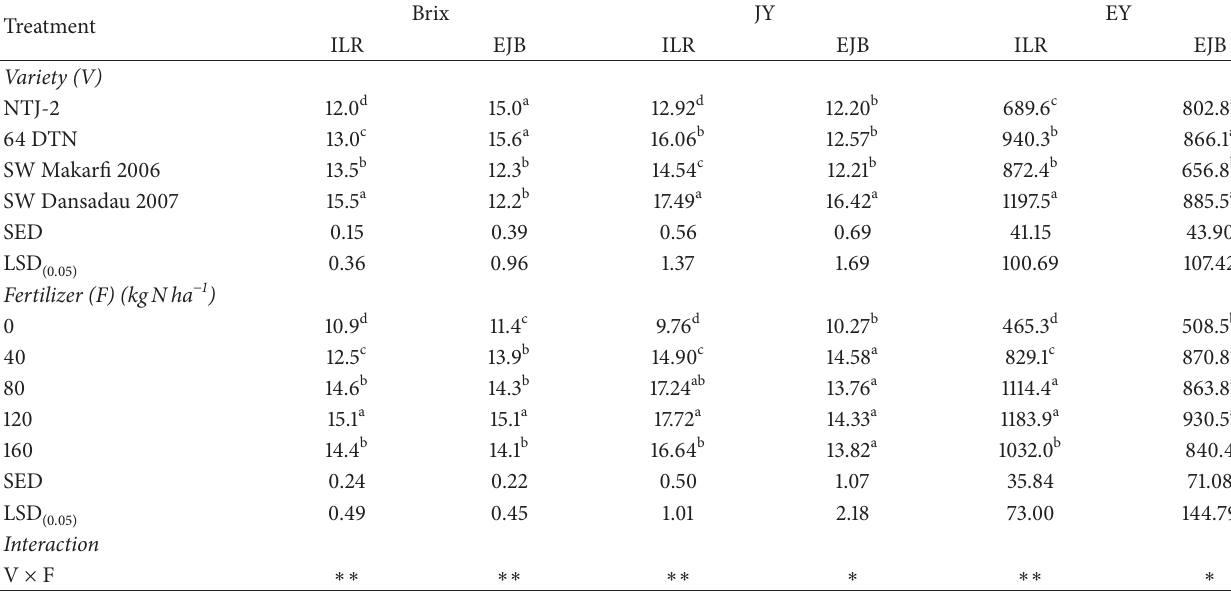
Table 5: Main effects of variety and N fertilizer on the brix (%), juice yield (JY, tha −1 ), and ethanol yield (EY, L ha −1 ) of sweet sorghum at the Ilorin (ILR) and Ejiba (EJB) experimental